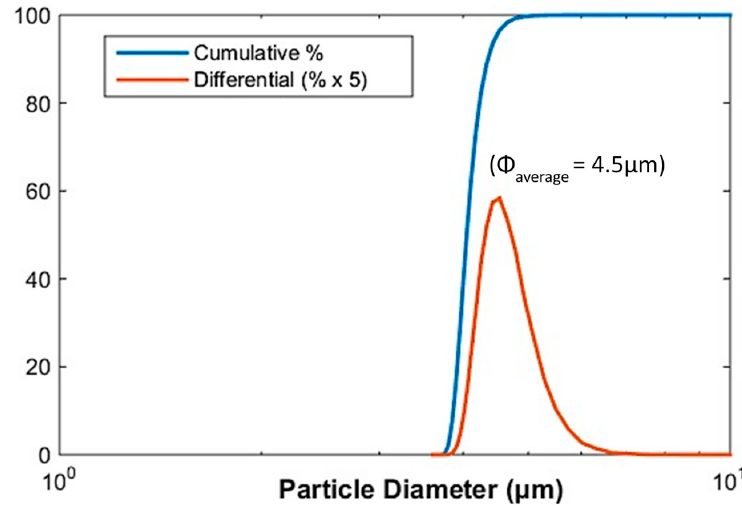
Figure 1. Particle size distribution of carbonyl iron particles (CIPs).